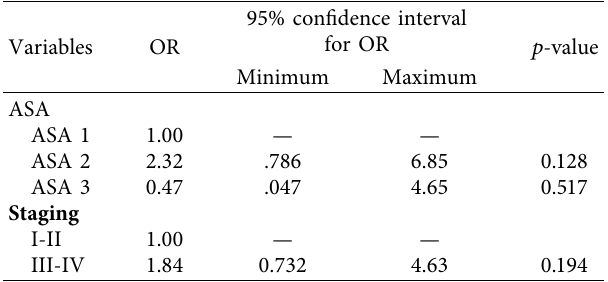
Prostate Table 6: Multiple logistic regression model with factors associated with postoperative complications in patients undergoing extended pelvic lymph node dissection.